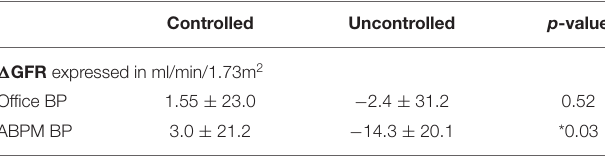
TABLE 4B | Results of PWV measurements.